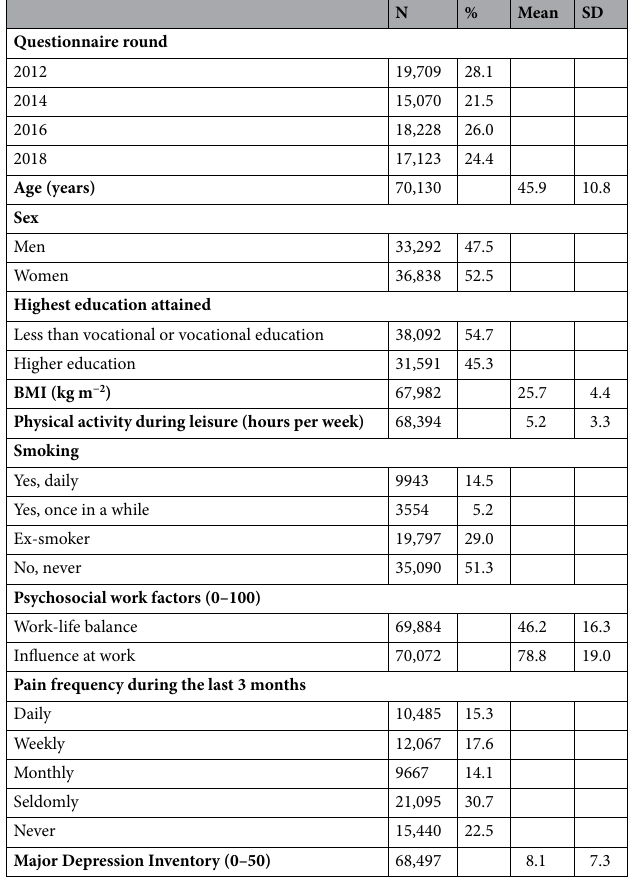
Table 1. Unweighted descriptive characteristics of the participants (N = 70,130) at baseline. Values are percentage of participants or mean and standard deviations